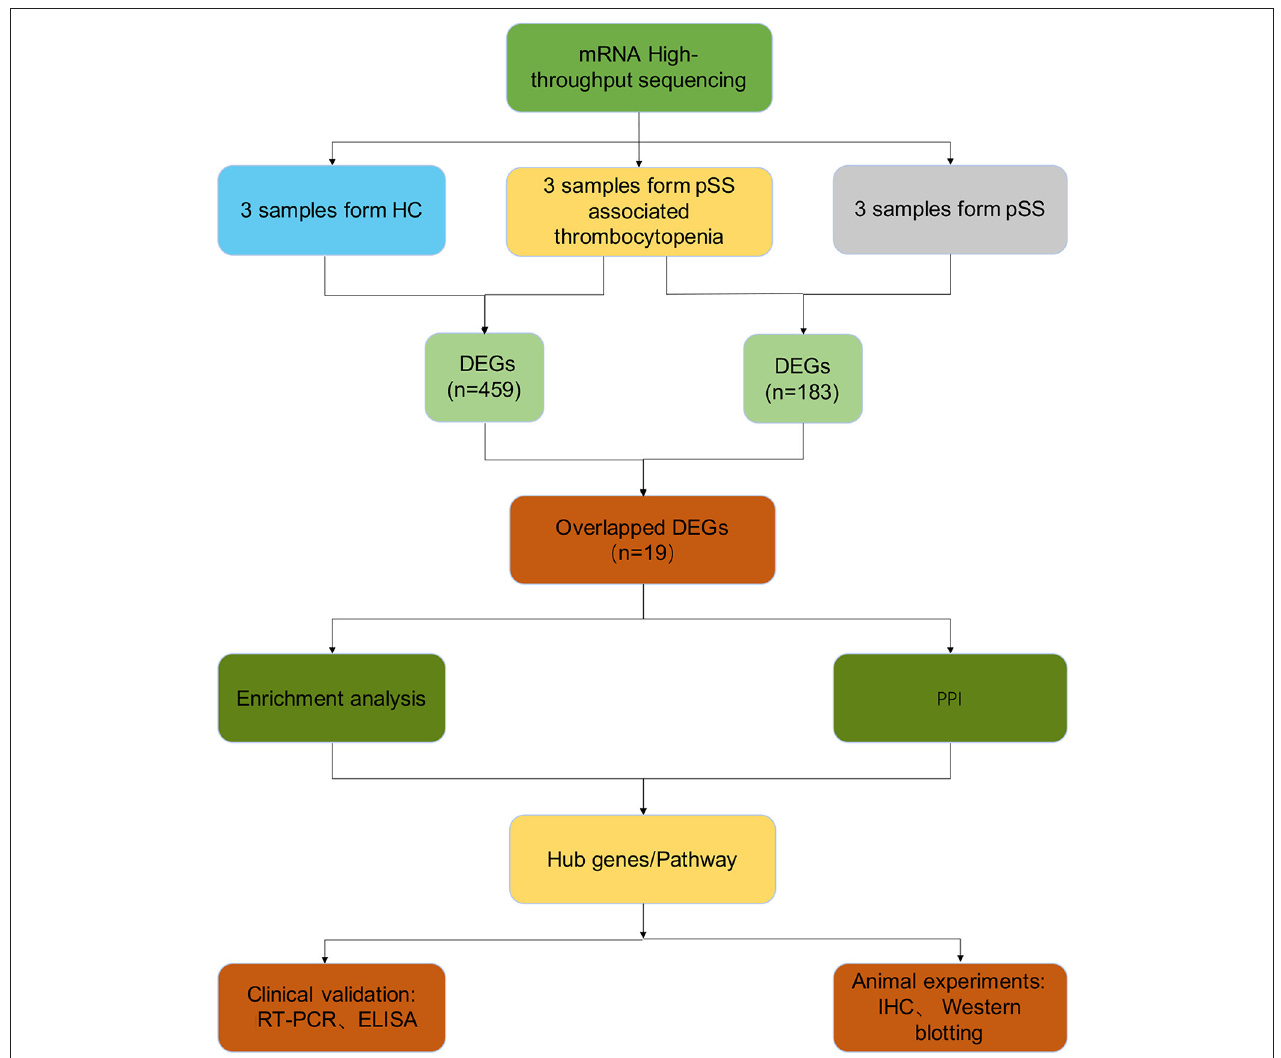
FIGURE 1 | Overview of the study design. HC, healthy control; pSS, primary Sjögren’s syndrome; DEGs, differentially expressed genes; PPI, protein-protein interaction; RT-PCR, real-time polymerase chain reaction; ELISA, enzyme-linked immunosorbent assays; IHC,